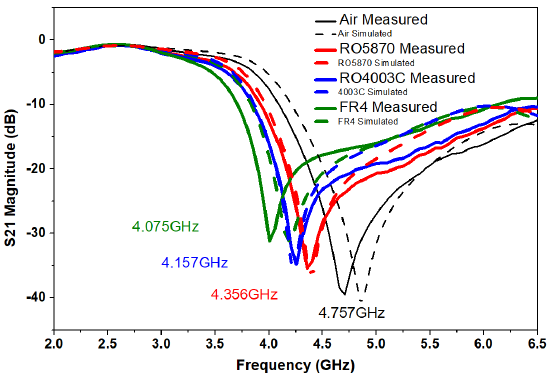
Figure 12. S 21 Measured results of metamaterial sensor with standard materials. Solid lines indicate measured results and dashed lines indicate simulated results.